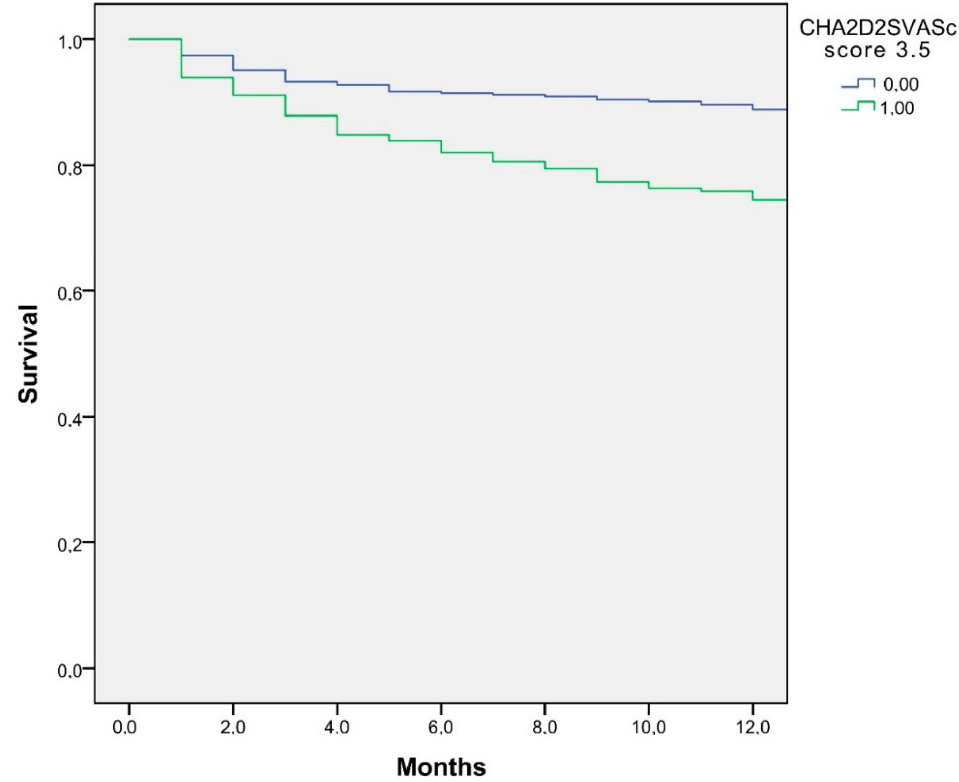
Figure 2. Figure 2. Kaplan–Meier curves displaying the estimated survival probability according to the CHA2DS2-VASc score ( p <